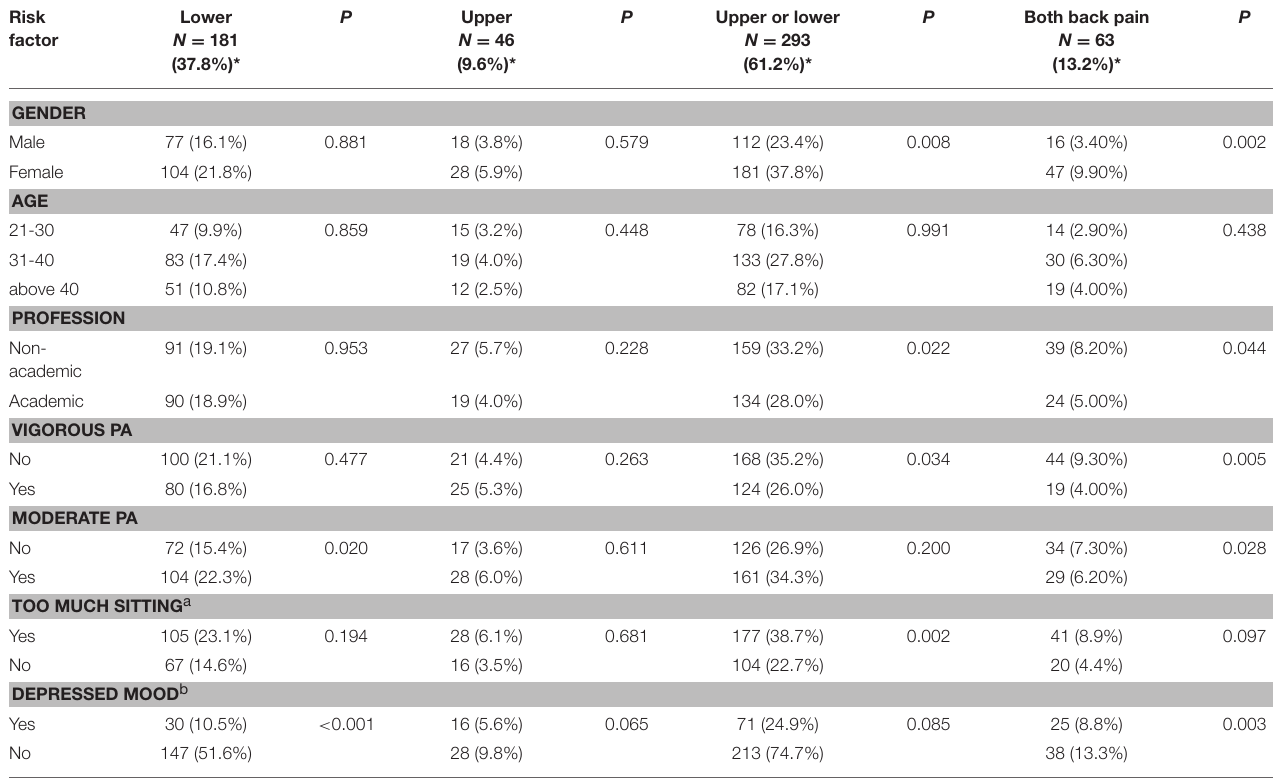
TABLE 1 | Baseline characteristics of the study population with any back pain (upper or lower) and those with both lower and upper back pain. Risk factor